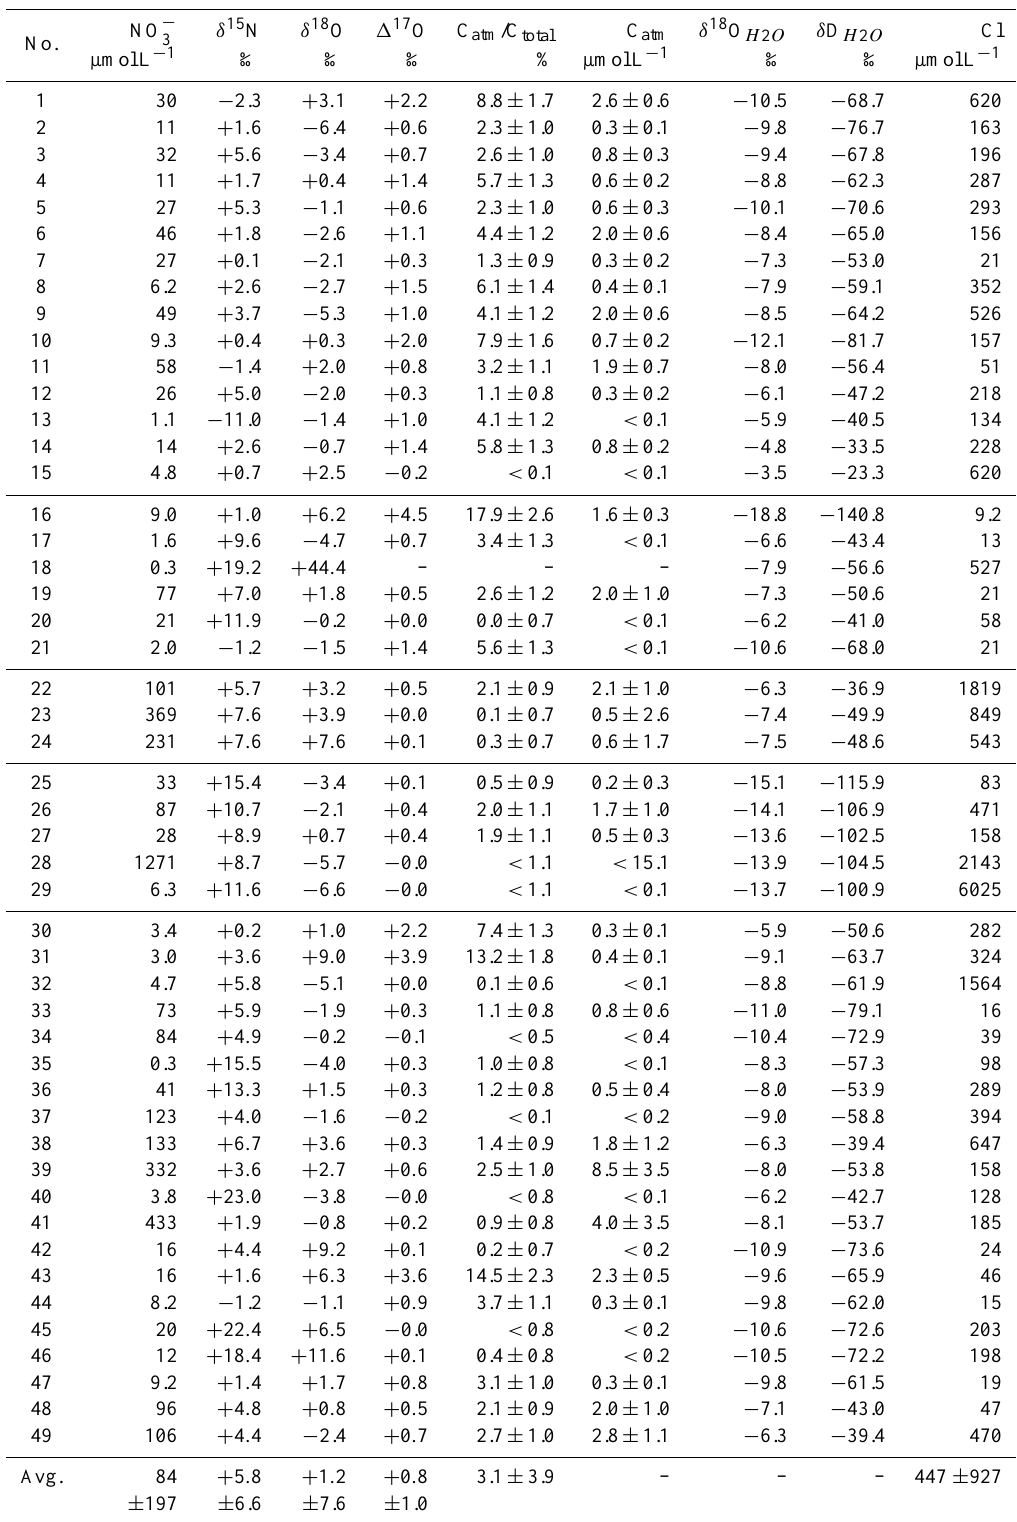
Table 2. Concentration and stable isotopic compositions ( δ 15 N, δ 18 O, and 1 17 O) of nitrate dissolved in the bottled water samples, together with the other